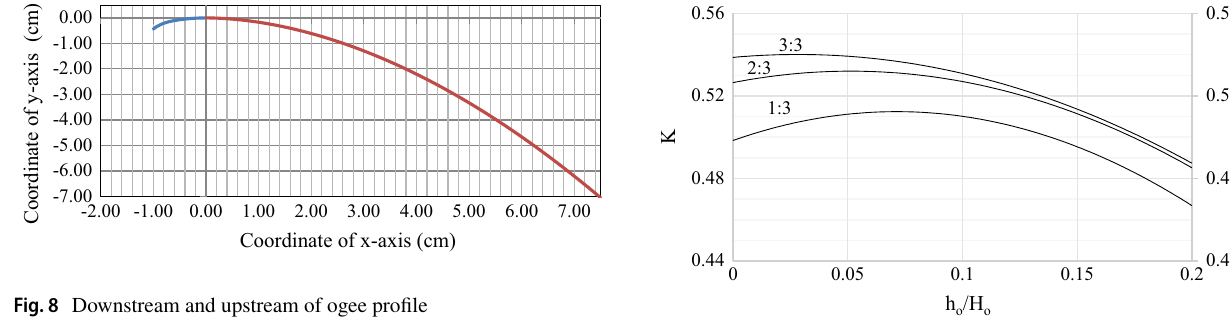
Fig. 8 Downstream and upstream of ogee profile Table 1 Coordinates for upstream portion of ogee profile and calcu-